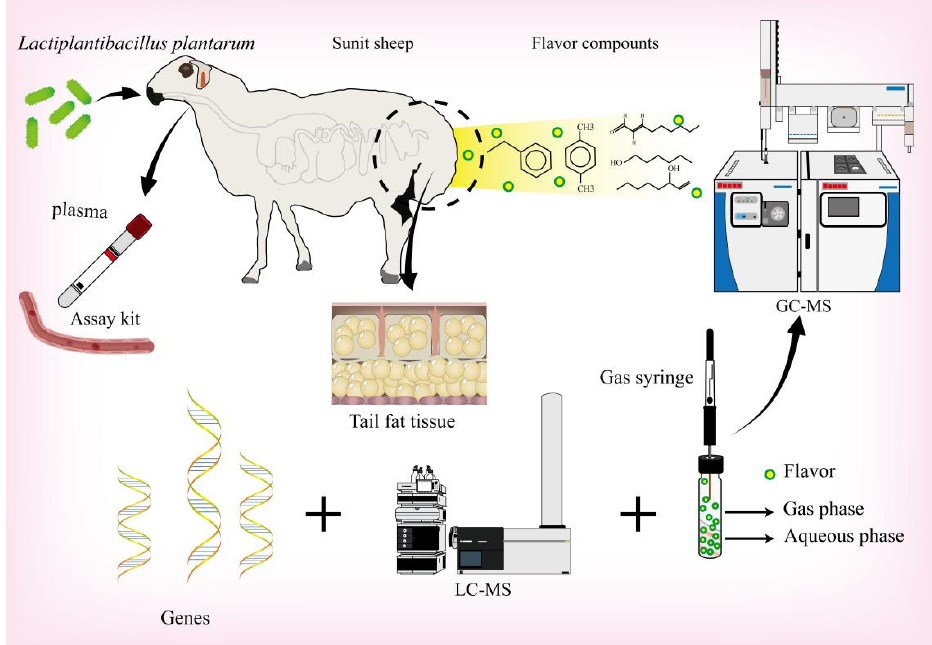
Figure 1. Experimental design diagram. Including animal experiments, RT-PCR experiments of genes related to lipid metabolism, GC-MS experiments of tail fat volatile flavor substances, and LC-MS metabolome experiments of tail fat.